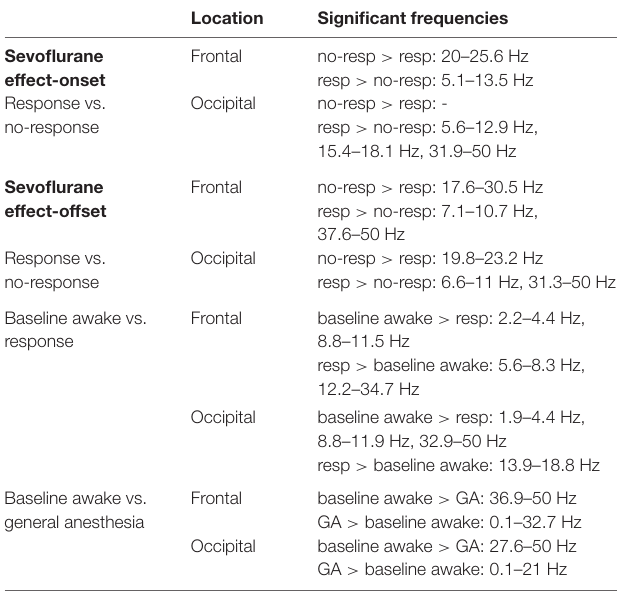
TABLE 1 | Significant differences in